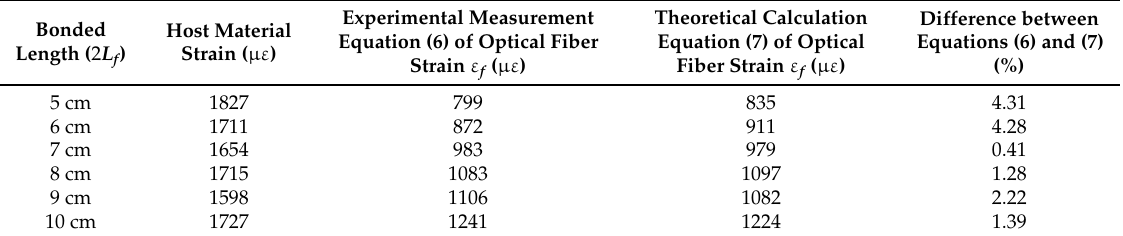
Table 5. Average strain of the optical fiber obtained by the experimental measurement Equation (6) and theoretical calculation Equation (7) with M-coat